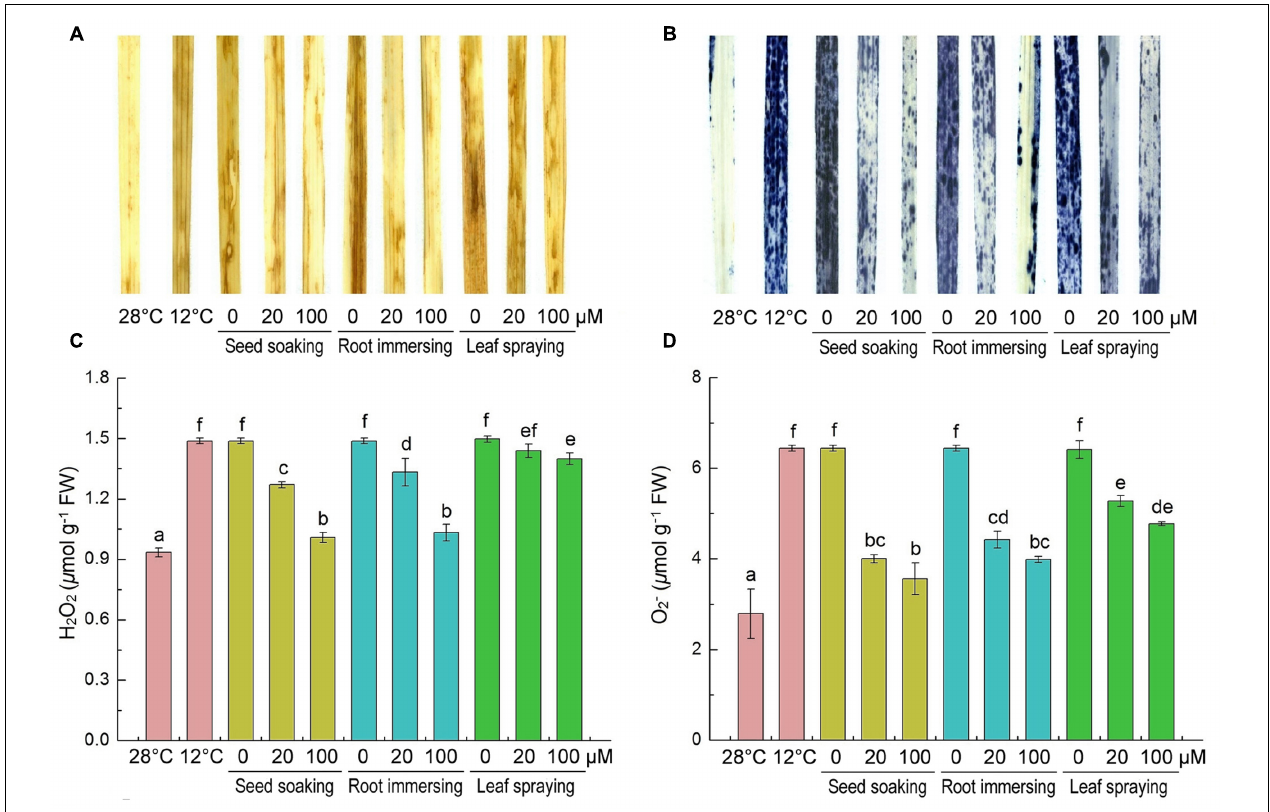
FIGURE 3 | Effects of exogenous melatonin on H 2 O 2 (A,C) , and O − 2 (B,D) after 6-day cold stress (12 ◦ C). Histochemical detection (A,B) and content (C,D) . Others are the same as in Figure 1 .